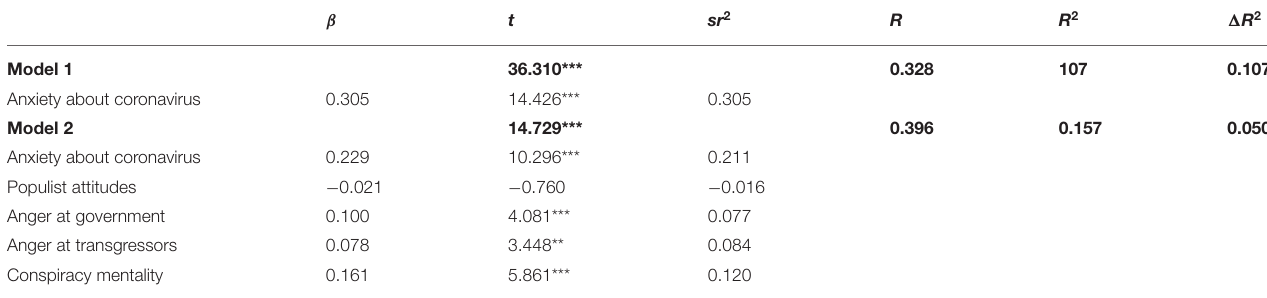
TABLE 5 | Hierarchical regression analysis for “compliance with hygiene measures” in three steps (standardized regression coefficients).